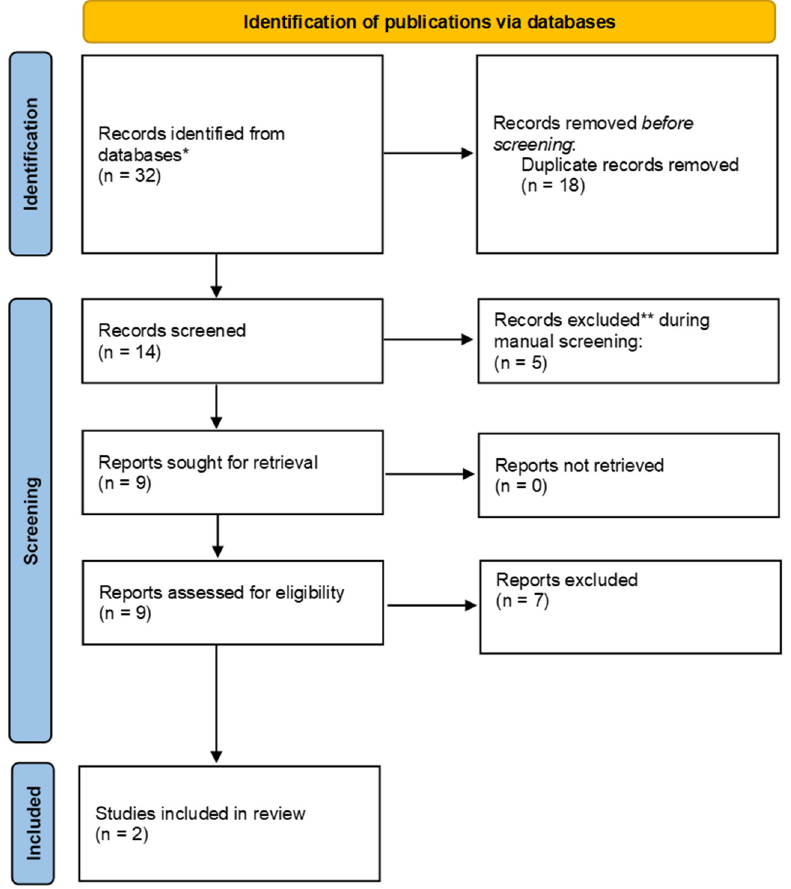
Figure 2. PRISMA flowchart visualizing the search and selection process. * Databases used: PubMed and Web of Science; ** reasons for exclusion: topic outside the scope of the review.